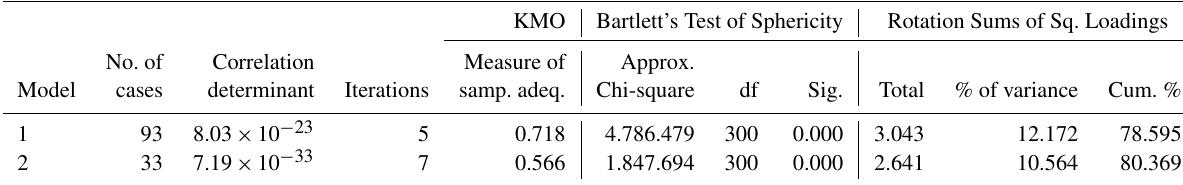
KMO Bartlett’s Test of Sphericity Rotation Sums of Sq.